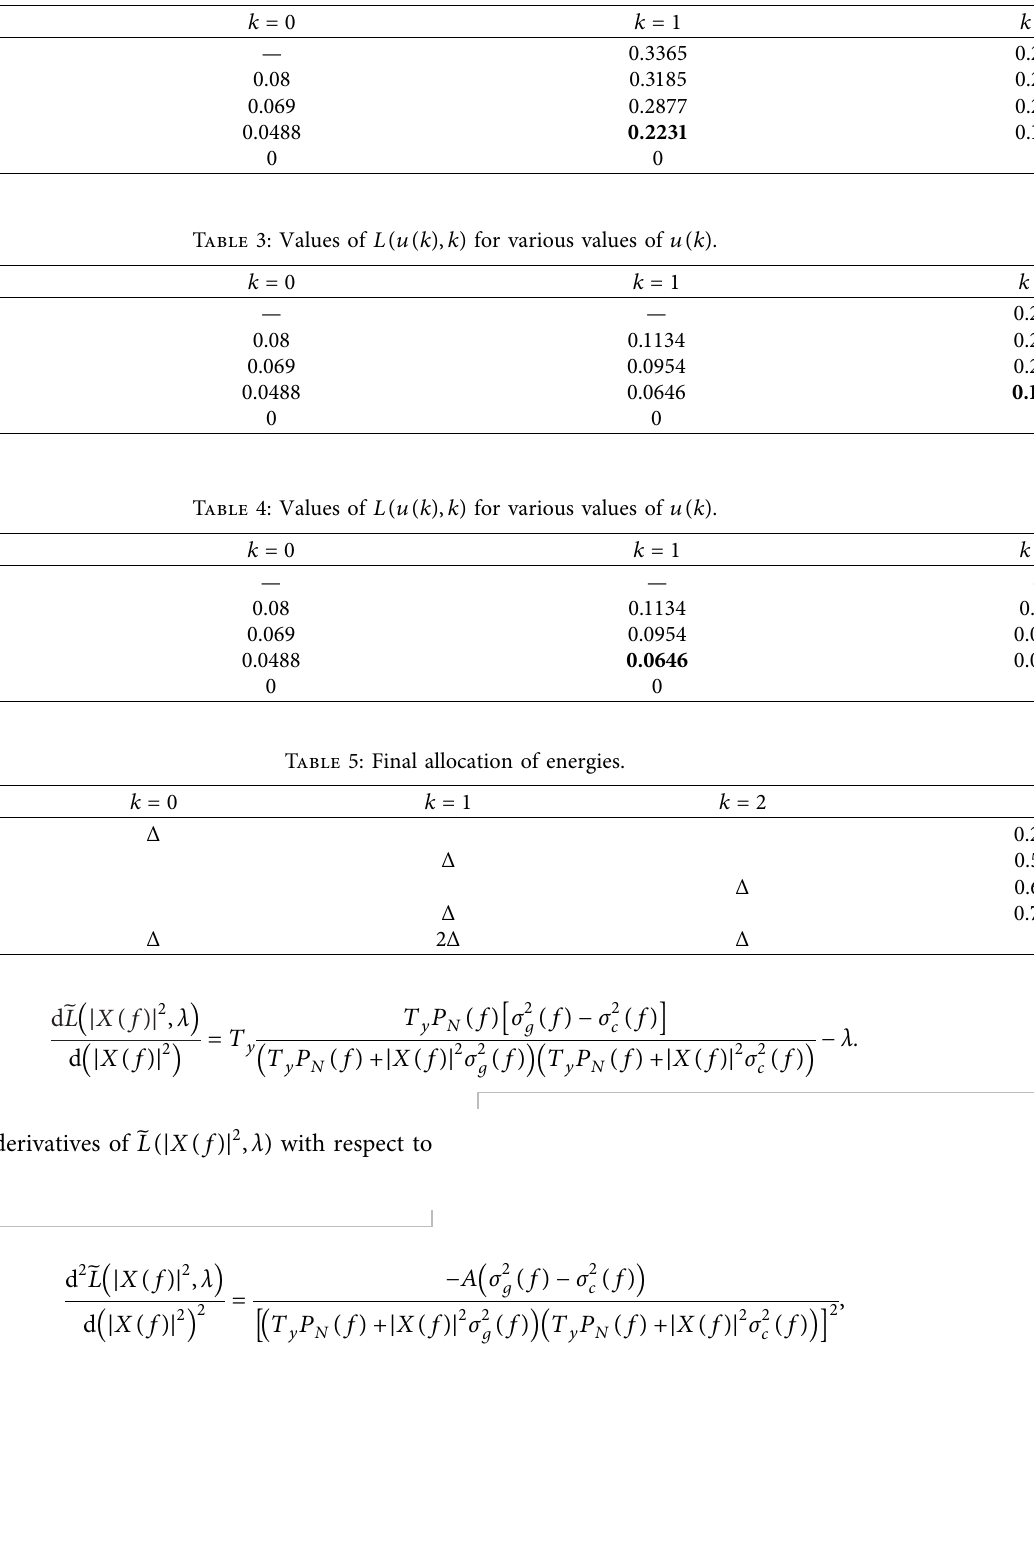
Table 2: Values of L ( u ( k ) ,k ) for various values of u ( k ) .